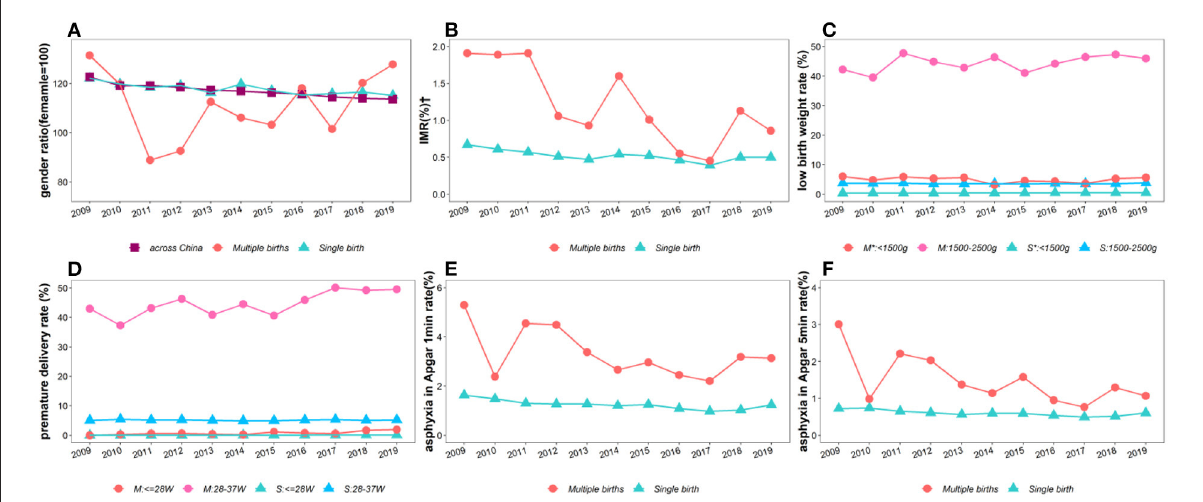
FIGURE2 Secular trends of the demographic and developmental characteristics among 526,654 newborns in Baoan, Shenzhen, 2009–2019. (A) Gender ratio, (B) Infant Mortality Rate (IMR), (C) neonatal weight, (D) neonatal gestational age, (E) asphyxia rate with Apgar score < 7 at 1min after birth, (F) asphyxia rate with Apgar score < 7 at 5min after birth. *526,654 newborns includes 515,016 singletons and 11,638 multiple births. M: multiple births; S: single birth. † Infant mortality refers to the death within 0–7 days of